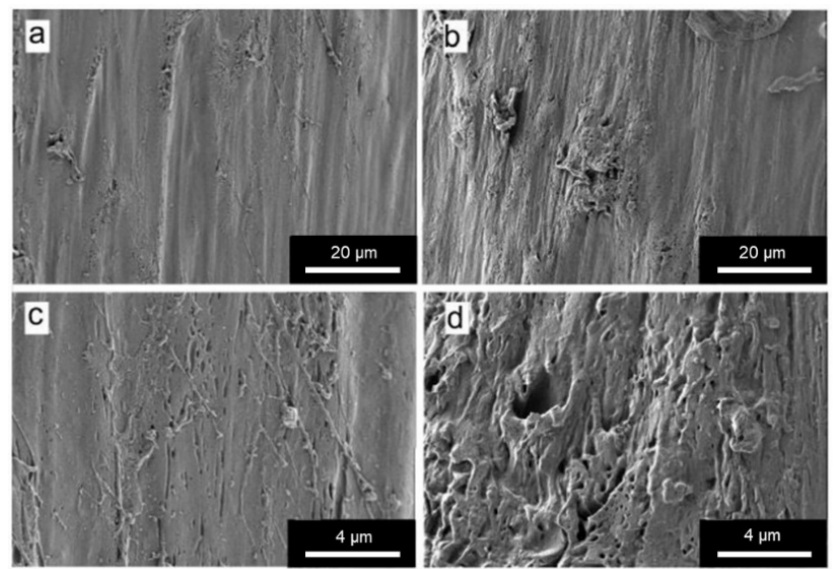
Figure 6. SEM micrographs of ( a ) and ( c ) FOMM filament; ( b ) and ( d ) wFOMM filament. Scale bars ( a ) and ( b ) = 20 μ m; ( c ) and ( d ) = 4 μ m.